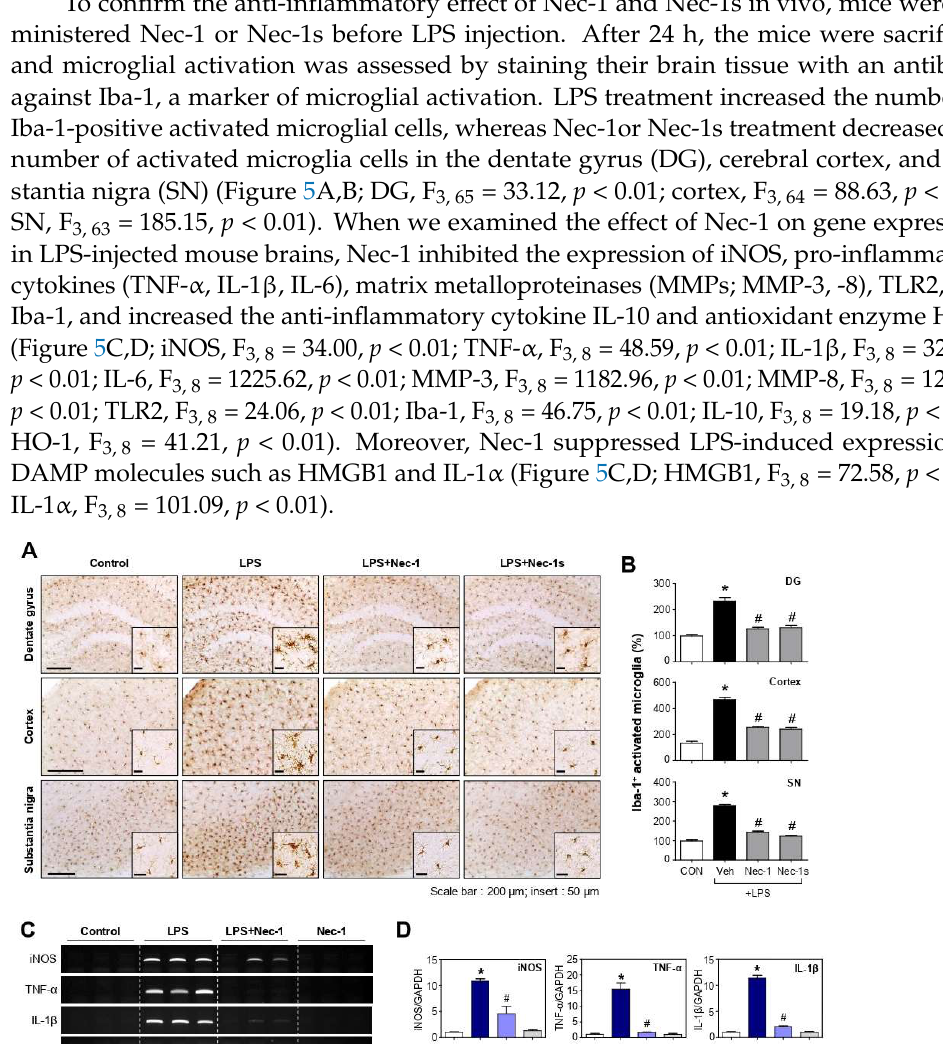
Figure 5. Effects of Nec-1 and Nec-1s on microglial activation and pro-/anti-inflammatory markers in the brains of LPS-injected mice. ( A ) Immunohistochemical staining for Iba-1 (microglial marker) and ( B ) quantification of the number of Iba-1-positive activated microglia 24 h after LPS injection (number of mice in each group n = 4–5). Microglial activation in the dentate gyrus (DG), cortex and substantia nigra (SN). Scale bars, 200 μm; insert, 50 μm ( C ) Effects of Nec-1 on the mRNA levels of iNOS, pro-inflammatory cytokines (TNF-α, IL-1β, IL-6), MMPs (MMP-3, MMP-8), TLR2, Iba-1, IL-10, HO-1, and DAMPs (HMGB1, IL-1 α ) in the cortex of LPS-injected mice. ( D ) Quantification data are shown. Data are shown as the mean ± SEM. * p < 0.05 vs. control group; # p < 0.05 vs. LPS